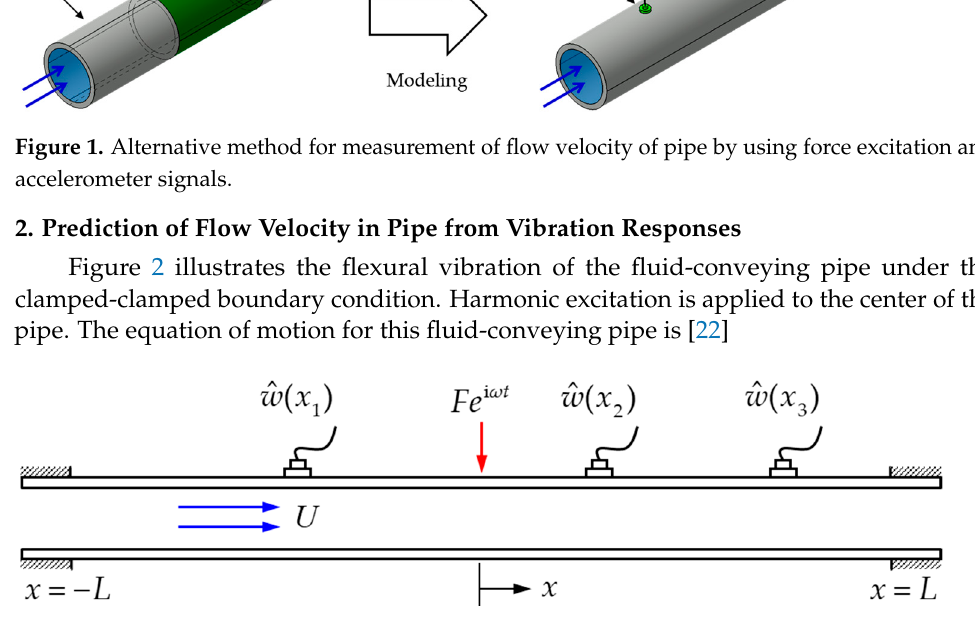
Figure 2. Analytical model of the flexural vibration of clamped-clamped fluid-conveying pipe with accelerometers attached to the outer surface at different positions.